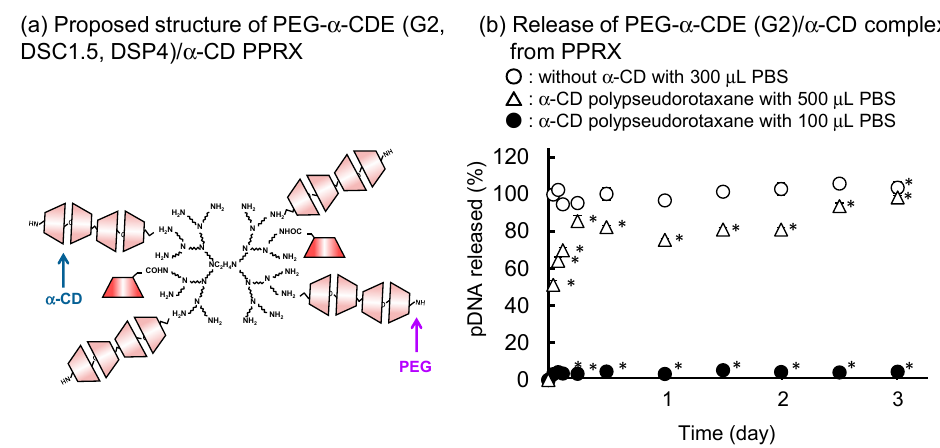
Figure 12. ( a ) Proposed structure of PEG- α -CDE (G2, DSC1.5, DSP4)/ α -CD PPRX and ( b ) in vitro release profiles of pDNA from PEG- α -CDE/pDNA/CDs polypseudorotaxanes in different volumes of phosphate-buffered saline (pH 7.4). * p <